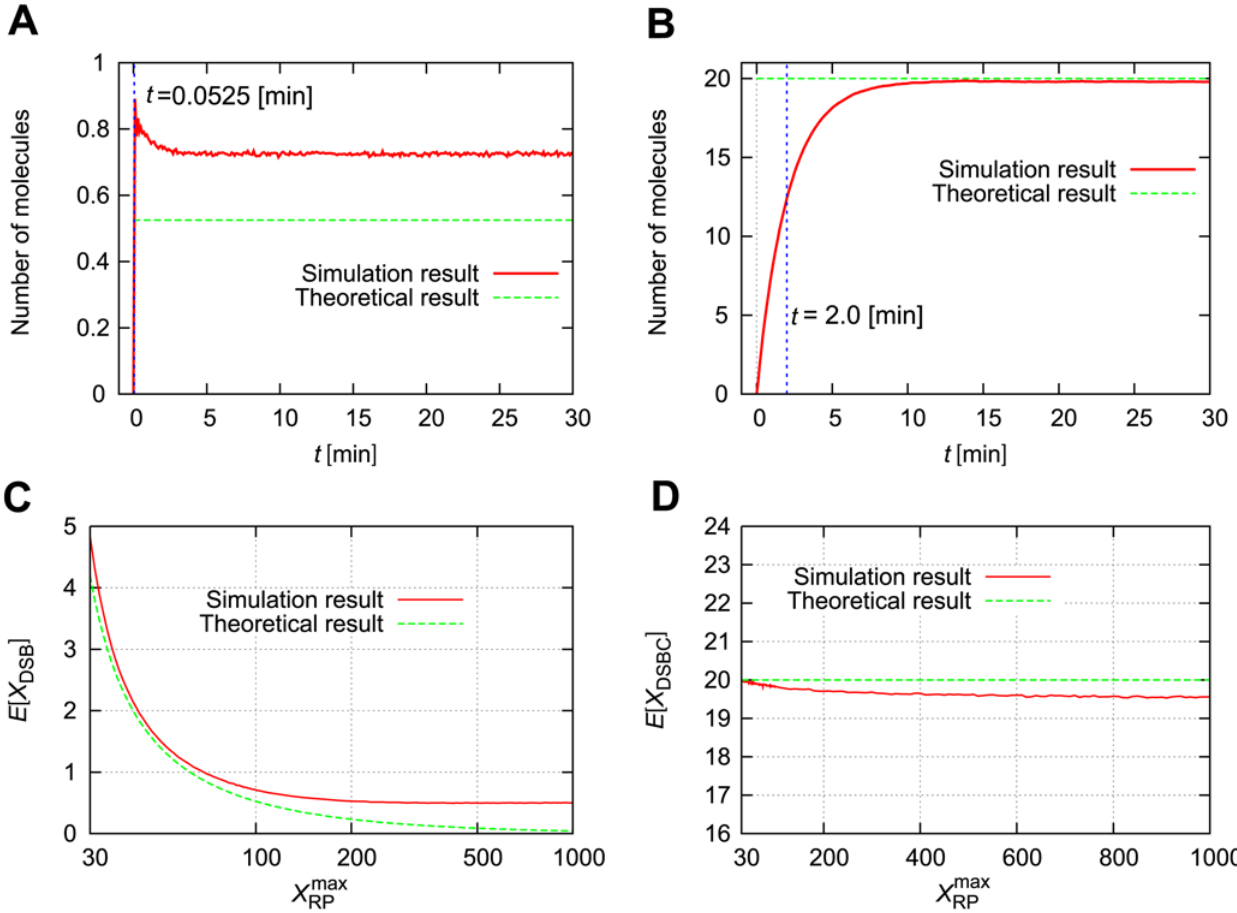
Figure 3. Theoretical mean values of DSBs and DSBCs are suitable for small X max ensemble average of the number of DSBs, E X DSB t ð Þ½ (cid:1) . The thin line denotes the theoretical value ( ^ XX DSB ~ 0 : 525 ). (B) The thick line denotes a simulation result of the ensemble average of the number of DSBCs, E X DSBC t ð Þ½ (cid:1) . The thin line denotes the theoretical value ( ^ XX DSBC ~ 20 : 0 ). The vertical dotted line denotes the theoretical time t DSB C ð Þ . (C, D) Comparisons of theoretical and simulation results for the mean of X DSB or X DSBC as a function of the maximum number of repair proteins ( X max X